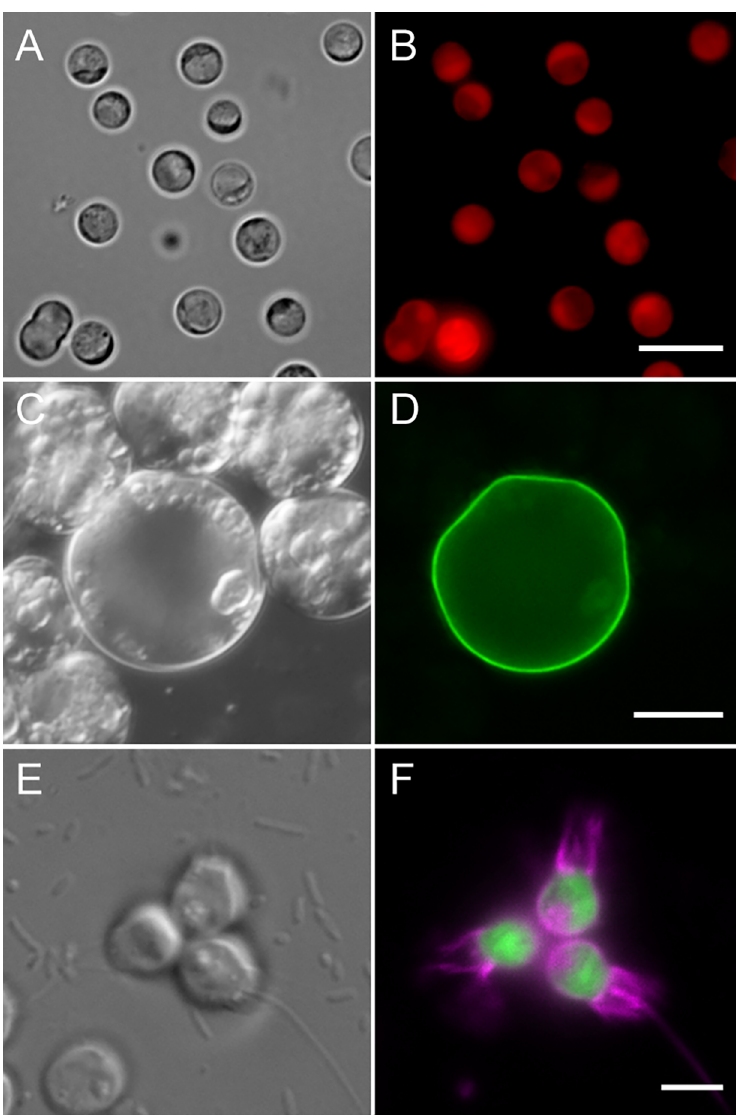
Fig 2. Examples of EMS transformed protists. (A, B) Corallochytrium limacisporum stably expressing the mCherry fluorescent protein (red) fused to a puromycin resistance protein driven by an endogenous actin promoter (M. Rubio- Brotons, UPF–CSIC, Barcelona, Spain). (C, D) Perkinsus olseni (marine bivalve parasite) expressing a GFP (green) fusion with an exported cell-wall protein (R. Waller, University of Cambridge, United Kingdom). (E, F) The choanoflagellate Salpingoeca rosetta transformed with a plasmid expressing fluorescent proteins that illuminate the cell body (green) and the plasma membrane (magenta) (D. Booth, University of California Berkeley, United States